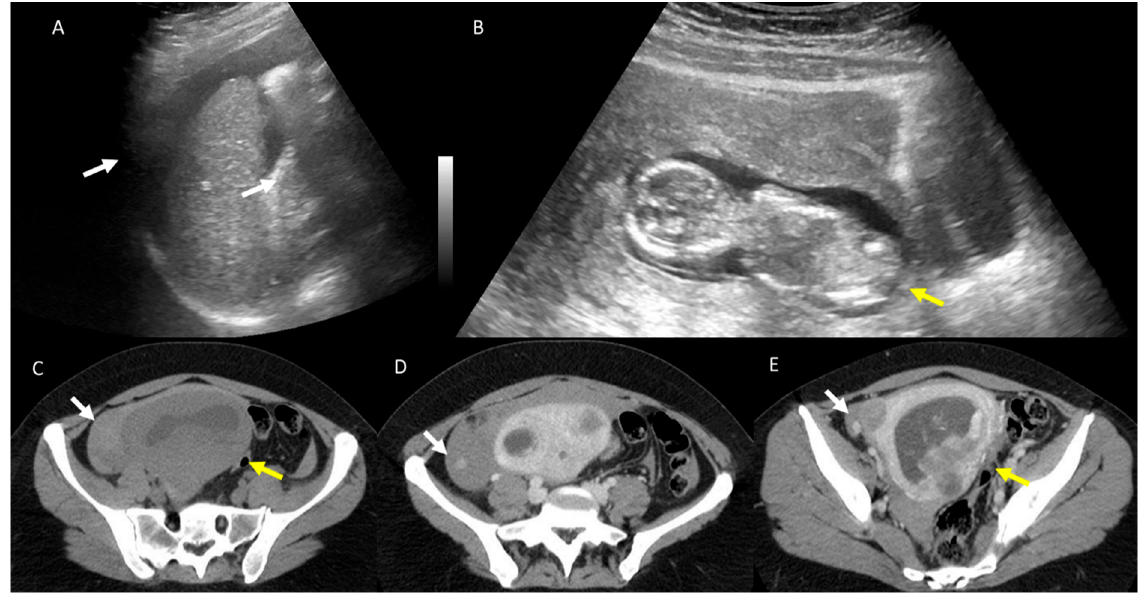
Figure 6. Polytraumatized (crash accident) pregnant woman (yellow arrows) admitted to emergency room. Fast US ( A and B ) shows abdominal free fluid. Unenhanced CT ( C ), white arrow shows intraabdominal blood with active bleeding (white arrows in D , E ) after contrast medium administration.